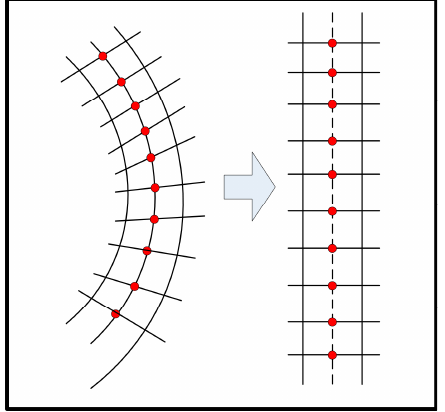
Figure 8. Schematic diagram of coastline straightening.